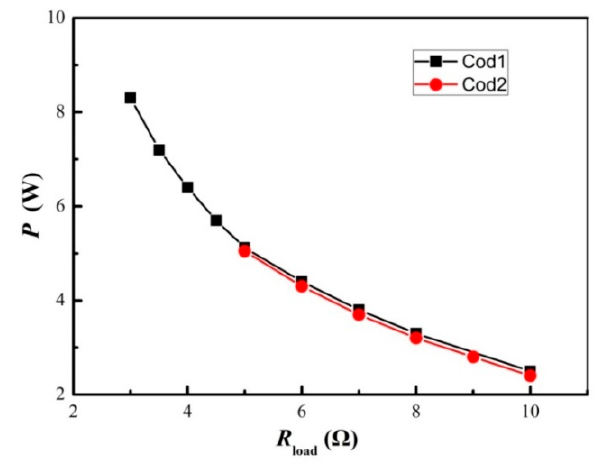
Figure 6. The power load feature of the STEG for different thicknesses of the heat conducting plate (HS1 heat sink, YNJAD cooling fans and Cof1 configuration).